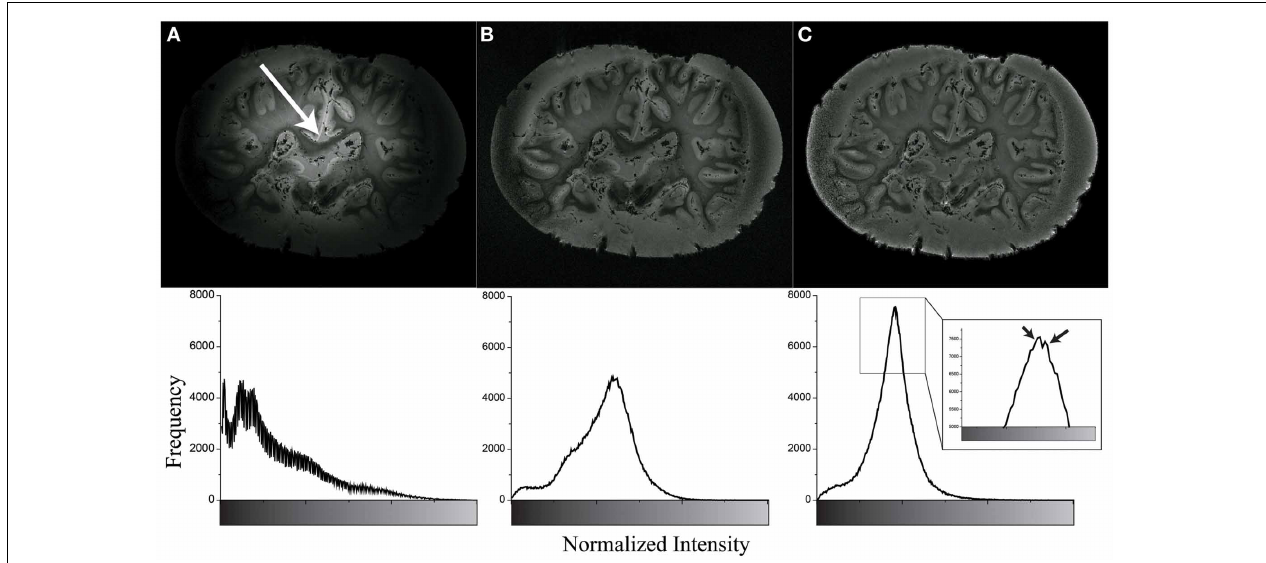
FIGURE 4 | Example of inhomogeneity correction of original image (A) using N4 bias field correction (B) and Gaussian filter based method (C). The bottom row shows their intensity histogram. The white arrow shows the center of hotspot. The black arrows show